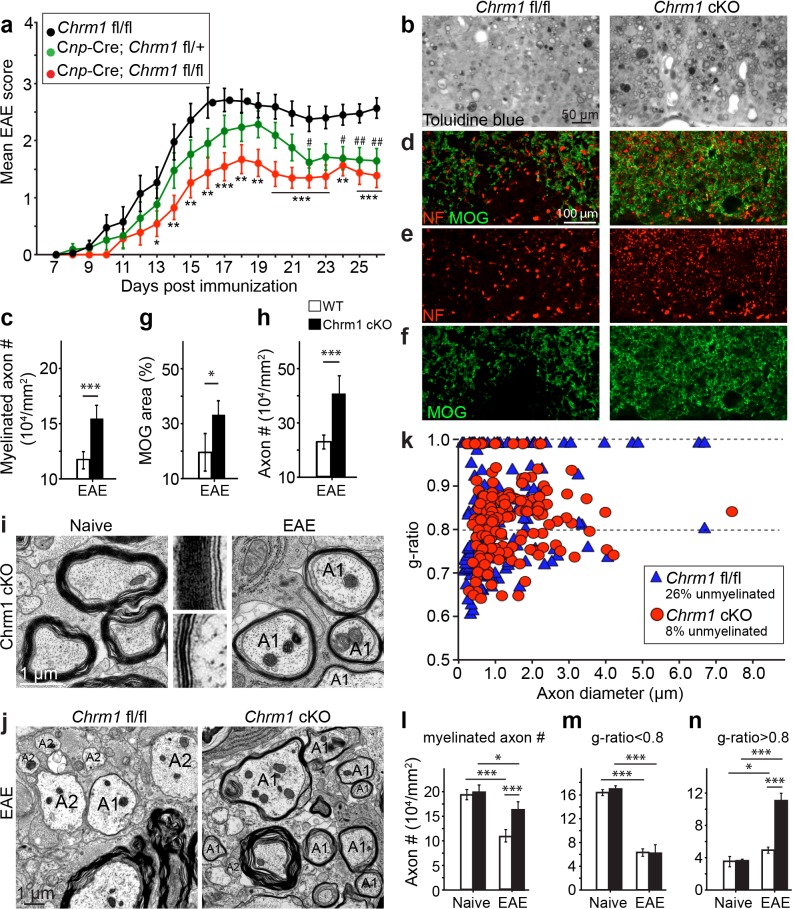
Accelerated remyelination prevents axonal loss and restores neuronal function in EAE.(a) The clinical severity in MOG35-55 induced EAE was reduced in the Chrm1 conditional knockout mice (Cnp-cre; Chrm1 fl/fl, n = 27) and Chrm1 conditional knockout heterozygotes (Cnp-cre; Chrm1 fl/+, n = 24) as compared to control (Chrm1 fl/fl, n = 23) littermates. Cumulative data shown represent mean ± s.e.m. from four independent experiments. Significance based on the Mann-Whitney test for individual days, *p or # < 0.05, **p or ## < 0.01 or ***p< 0.001. (b) Spinal cord semi-thin sections stained with toluidine blue from Chrm1 cKO and control EAE mice. (d–f) Spinal cord cross sections stained with MOG (green) and NF (red) showing myelin and axonal density in Chrm1 cKO and control EAE mice (d–f). (c, g, h) Quantification of myelinated axons (c), MOG+ density (g) and NF+ axon numbers (h) from the Chrm1 cKO and control EAE mice. (i) Representative electron microscopic image of pre-existing myelinated axons and remyelinated axons (A1) in the spinal cord white matter tracts of Chrm1 cKO naïve and EAE mice respectively. (j) Remyelinated (A1) and demyelinated (A2) axons in the EAE Chrm1 cKO and control mice. (k) Quantification of myelin sheath thickness and the proportion of myelinated and unmyelinated axons in Chrm1 cKO (red) and control (blue) EAE mice. The scatterplot displays g-ratios of individual axons as a function of axonal diameter. Quantification of myelinated axons (i), and axons with g-ratio < 0.8 (m) or > 0.8 (n) in the EAE and naïve spinal cord of Chrm1 cKO and control mice. Error bars represent mean ± s.e.m. (3 representative animals in each group), and all experiments were performed in triplicate. Significance based on Student’s t-test with the respective controls.